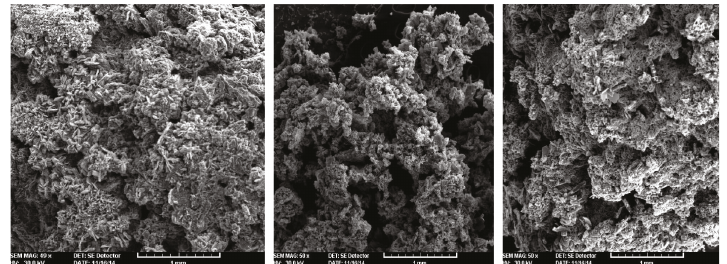
Figure 2: Microstructure of PPy samples where ferric chloride was used as an oxidizing agent (oxidant 0.1M, pyrrole 0.05M, and surfactant 0.025M at 25 ° C and duration of 4h).